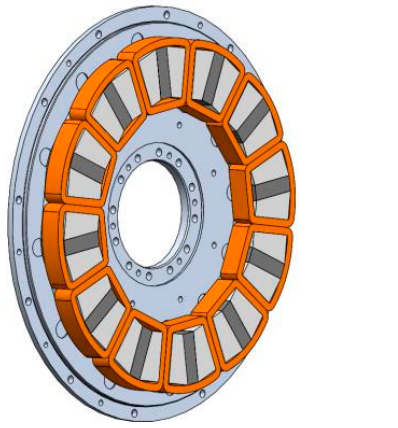
Figure 1. ( a ) Demonstration of the stator windings; ( b ) photo of the windings of the prototype.